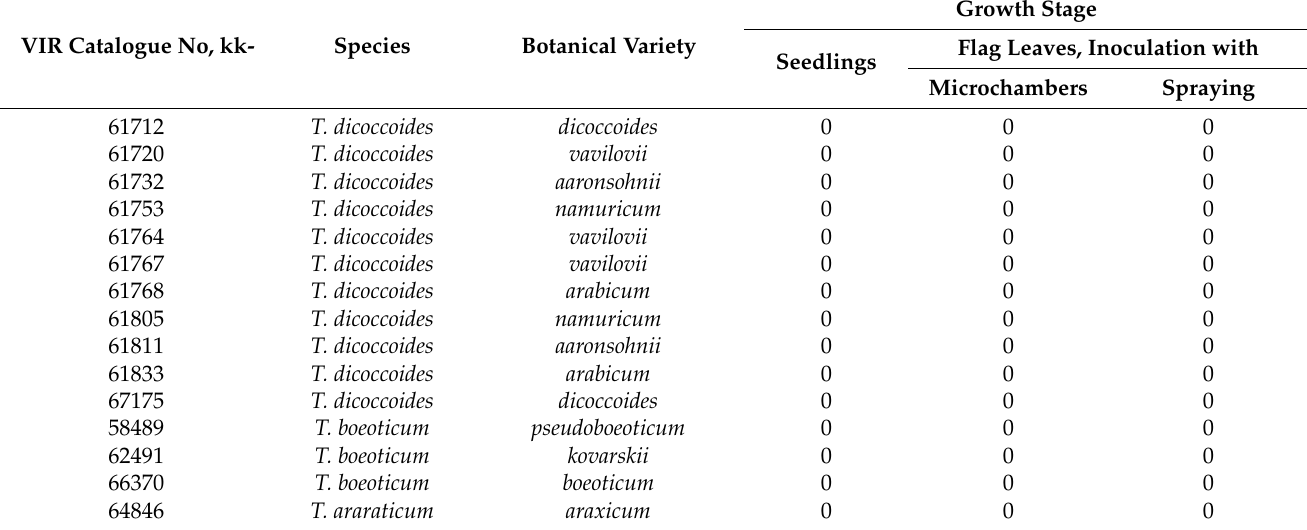
Table 4. Samples of wild wheat species from the VIR collection that are highly resistant to powdery